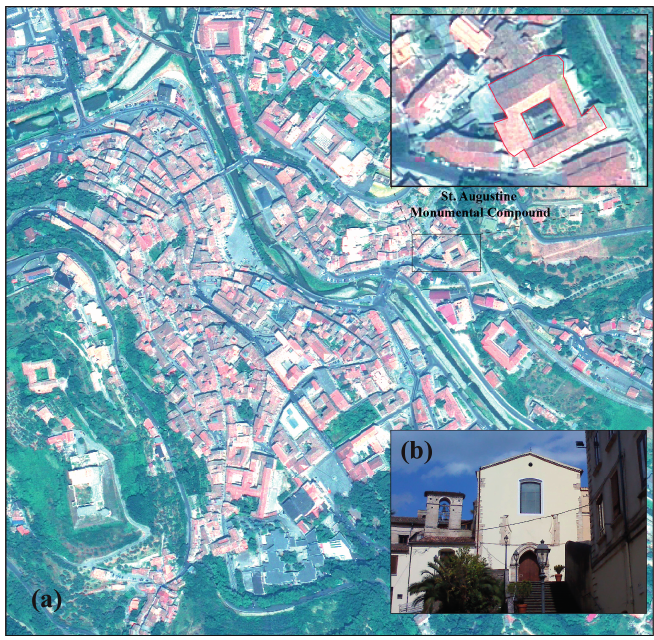
Figure 1. Historical centre of Cosenza indicating the location of ( a ) the St. Augustine Monumental Compound and ( b ) a picture of the church